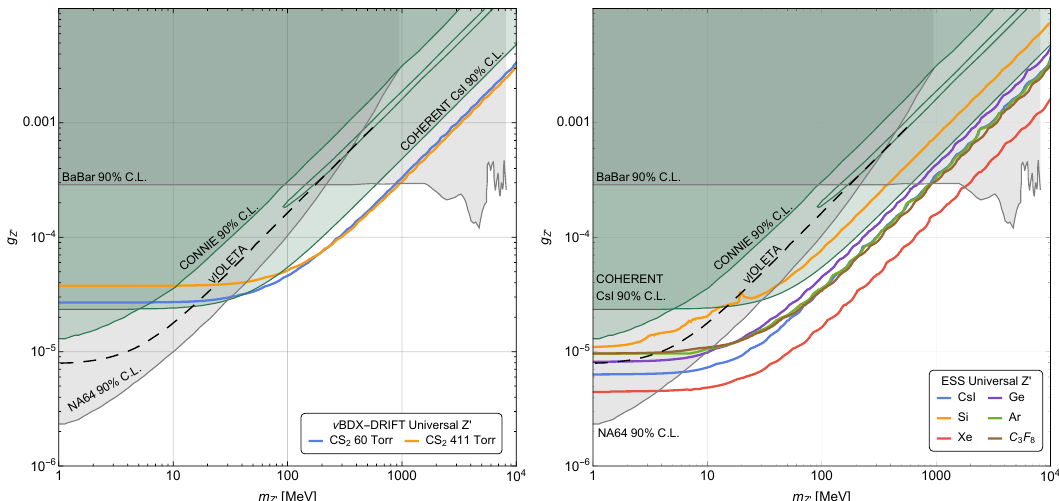
Figure 2. Future sensitivity at 90% C.L. in the m Z 0 − g Z 0 plane for the universal Z 0 model for the ν BDX-DRIFT detector (left) exploiting CS 2 at two different pressures, and the various detectors described in the text at the ESS (right). The dark green regions are excluded at 90% C.L. by CONNIE [34] and COHERENT [35] assuming dominant Z 0 decays to SM states. The dashed black curve shows the sensitivity of ν IOLETA [12]. The gray shaded areas are excluded at 90% C.L. by BaBar [36] and NA64 [37, 38] assuming that the Z 0 decays dominantly in invisible dark sector